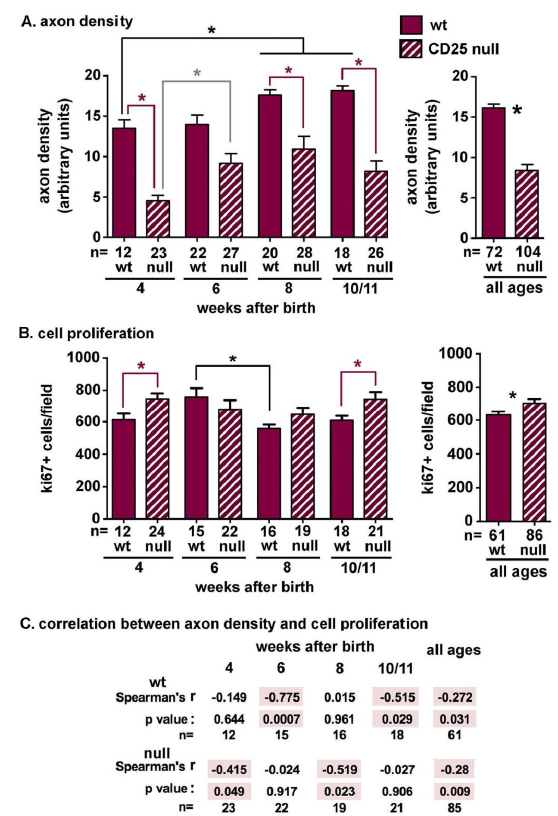
Figure 3. ICN density is reduced and corneal epithelial cell proliferation is increased in CD25 null corneas. ( A ) ICN density for male and female corneas were combined to allow us to determine the differences between genotypes and over time as corneas mature. The numbers of corneas used for each assessment are shown beneath each bar. Using ANOVA to compare the axon densities for all ages (4, 6, 8, 10/11) for wt corneas, shows a significant increase between 4 wk and 8 and 10 wk (black bar and asterisk). For CD25 null corneas, axon density increases between 4 and 6wk (grey bar and asterisk); at 8 and 10/11 wk, axon densities for CD25 null corneas are not significantly different from those seen at 4 or 6 wk by ANOVA. By t test, CD25 null axon density is significantly reduced as compared to wt at 4, 8, and 10/11 wk (maroon bar and asterisk). Combining axon densities for all ages confirms that CD25 null corneas have significantly reduced axon density. ( B ) Corneal epithelial cell proliferation was determined by quantifying the numbers of ki67+ cells per field. The numbers of corneas used for each assessment are shown beneath each bar. Proliferation data for male and female corneas were combined. Using ANOVA to compare proliferation for all ages (4, 6, 8, 10/11) for wt corneas shows no significant difference between 4 and 6 wk; however, between 6 and 8 wk, there is a reduction in cell proliferation (black bar and asterisk). Between 8 and 10/11 wk, cell proliferation does not change. Using ANOVA to compare proliferation for all ages (4, 6, 8, 10/11) for CD25 null corneas shows no significant difference at any time point. By t test, CD25 null proliferation is significantly elevated as compared to wt at 4 and 10/11 wk (maroon bar and asterisk). Combining cell proliferation data for all ages confirms that CD25 null corneas have significantly elevated cell proliferation compared to wt. ( C ) To determine how corneal epithelial cell proliferation varies with axon density, we calculated Spearman correlation coefficients for the paired values for axon density and cell proliferation from individual wt and CD25 null male and female corneas. Data for both sexes were combined. Data shows that in wt corneas, there is a significant negative correlation between cell proliferation and axon density at 6 and 10/11 wk and in CD25 null corneas there is a significant negative correlation between cell proliferation and axon density at 4 and 8 wk. Combining data for all ages confirms the negative correlation between cell proliferation and axon density for both